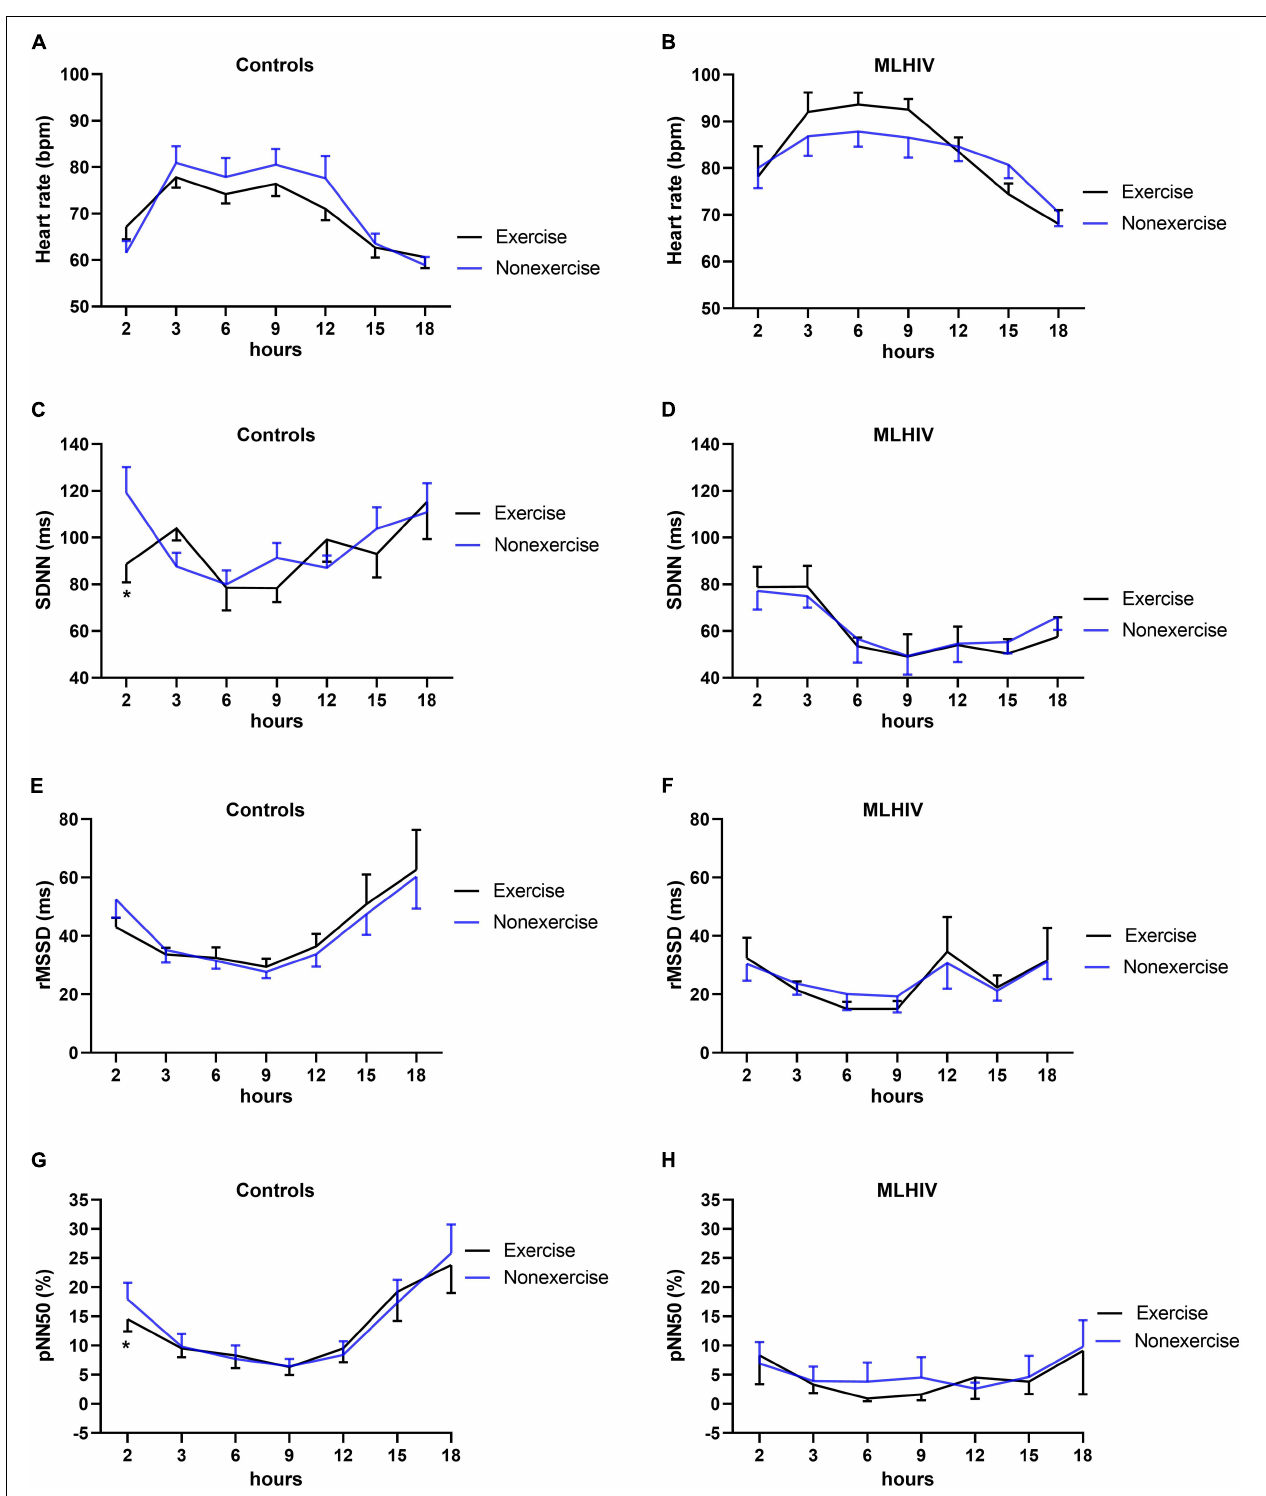
FIGURE 5 | Heart rate (A,B) and heart rate variability indices (C–H) during 18 h ambulatory blood pressure monitoring after exercise or non-exercise sessions in controls and men living with HIV (MLHIV). SDNN, standard deviation of normal to normal intervals; rMSSD, root mean square of successive differences between normal intervals; pNN50, percentage of differences between adjacent normal intervals. * p < 0.05 for changes from baseline (exercise vs. non-exercise session) using linear mixed models.